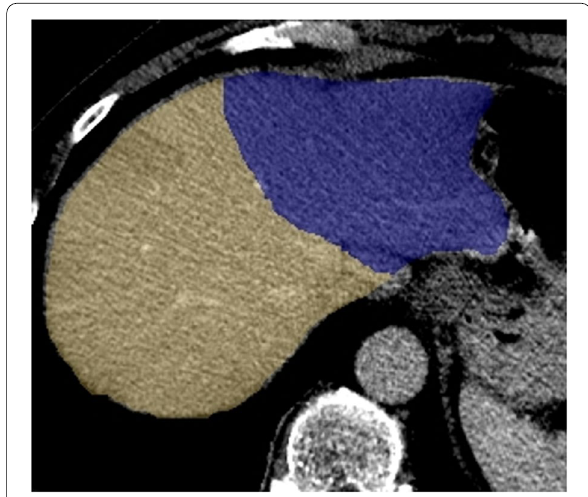
Fig. 3 Semi-automated segmentation of contrast enhanced CT of the liver into left and right